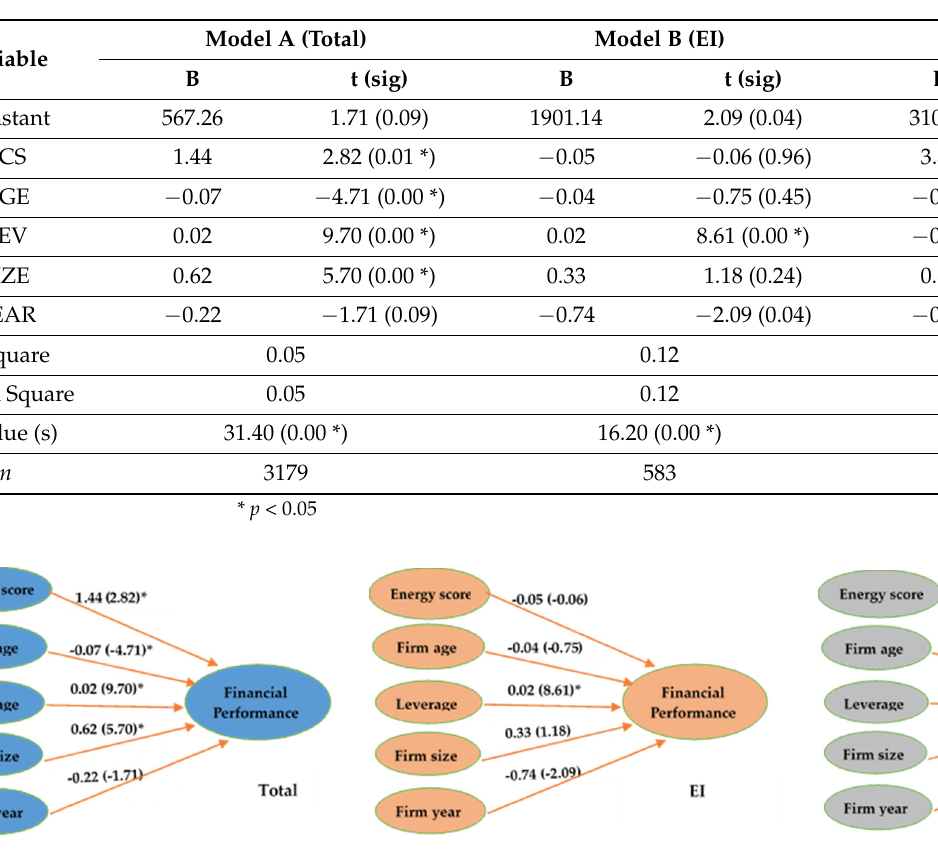
Table 7. Results of regression models.